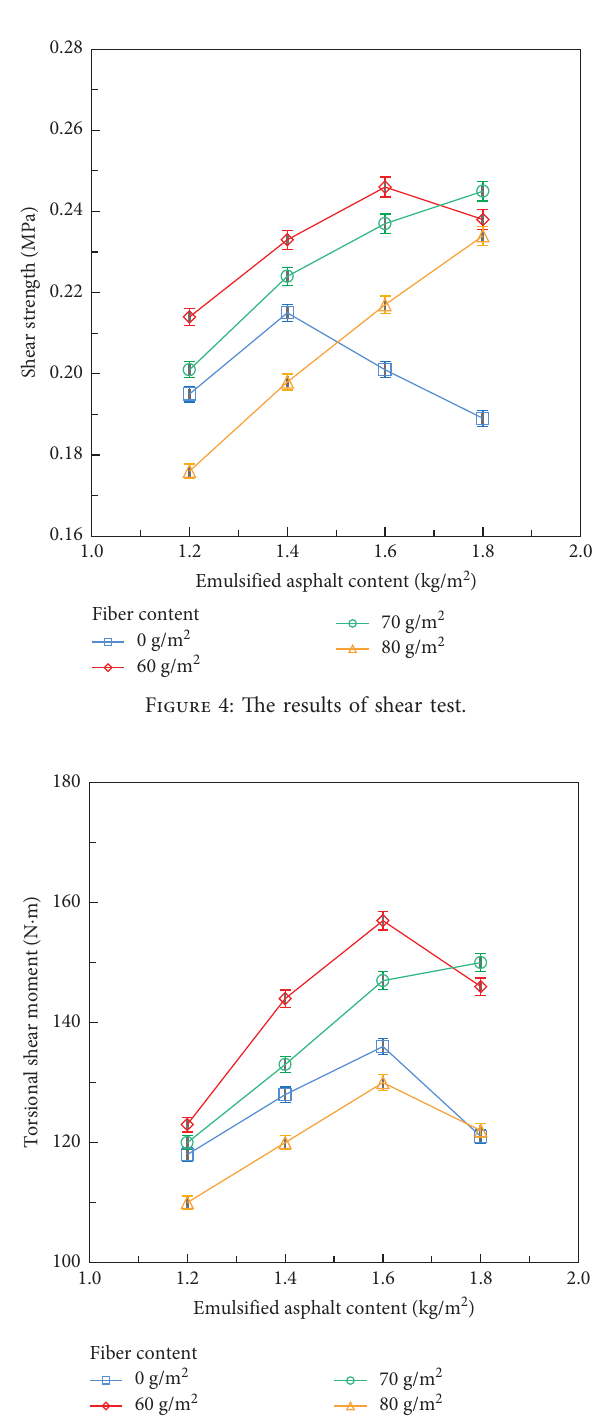
Figure 5: The results of torsional shear